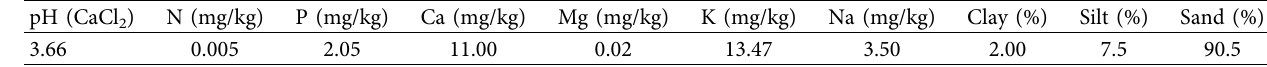
Table 2: Chemical and physical properties of soil used in the